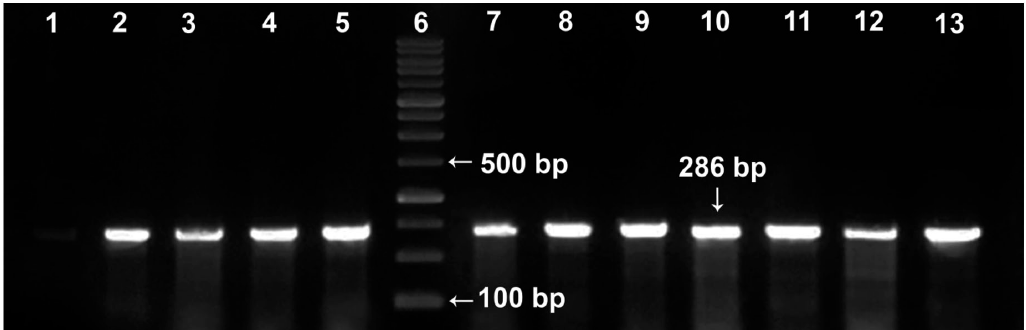
Fig. 1 . Representative agarose gel (2%) viewing PCR amplification of mec A gene (286 bp). Lane 6: DNA molecular weight marker (100-bp ladder). Lane 1: methicillin-sensitive S. aureus (MSSA strain, ATCC 25923, negative control); lane 2: positive control (MRSA, ATCC 43300); lanes 3–5 and lanes 7-13: representative MRSA isolates from the study.